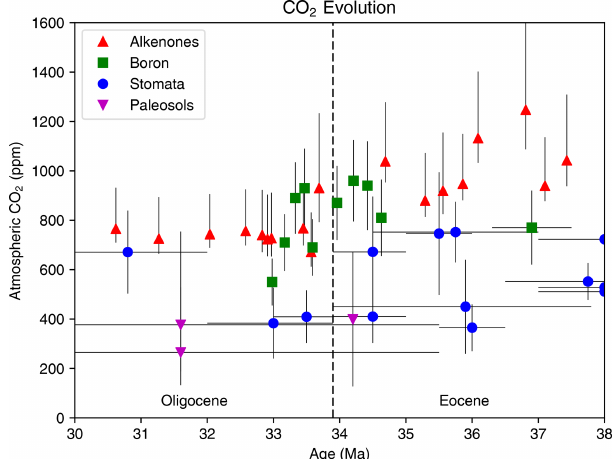
Figure 5. Atmospheric CO 2 evolution from 44 to 24Ma from the compilation of Foster et al. (2017), incorporating data from its original data sources (Anagnostou et al., 2016; Doria et al., 2011; Erdei et al., 2012; Franks et al., 2014; Pearson et al., 2009; Roth- Nebelsick et al., 2012, 2014; Steinthorsdottir et al., 2016, 2019; Zhang et al.,